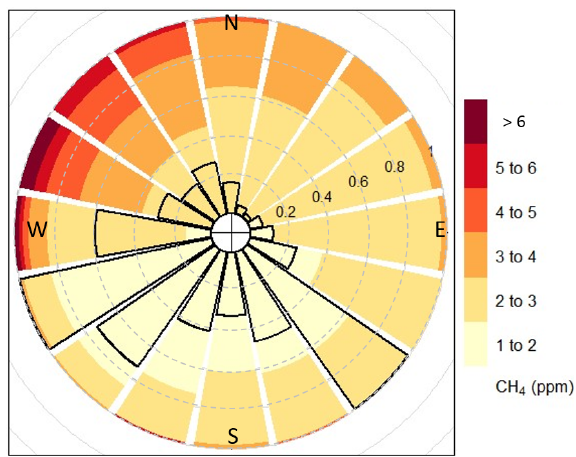
Figure 5. Rose plot of CH 4 mole fraction at 18m. Colors represent CH 4 mole fraction. The length of each colored segment represents the time fraction of that mole fraction range in each direction bin. The radius of the black open sectors indicates the frequency of wind in each direction bin; the angle represents wind